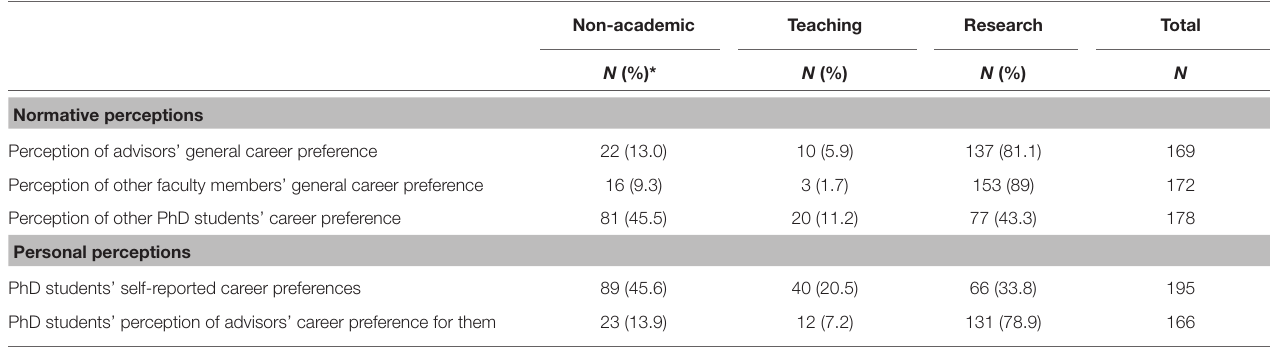
TABLE 2 | Frequency table for PhD student’s self and perceived others’ career